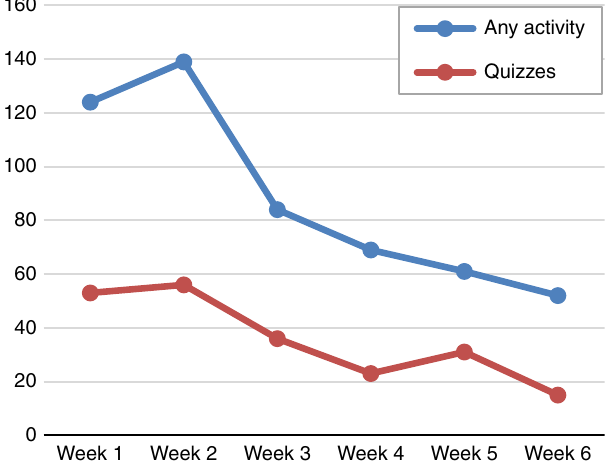
(based on any activity and quizzes) from the Dr Internet